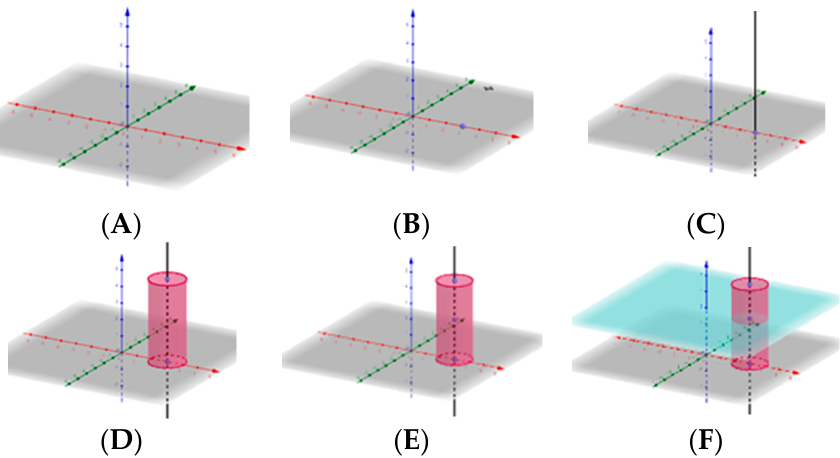
Figure 7. Procedures for building a level-plane cylinder section. ( A ) Planes, ( B ) point, ( C ) recta, ( D ) Cylinder, ( E ) point for the cutting plane and ( F ) Parallel plane of Level.